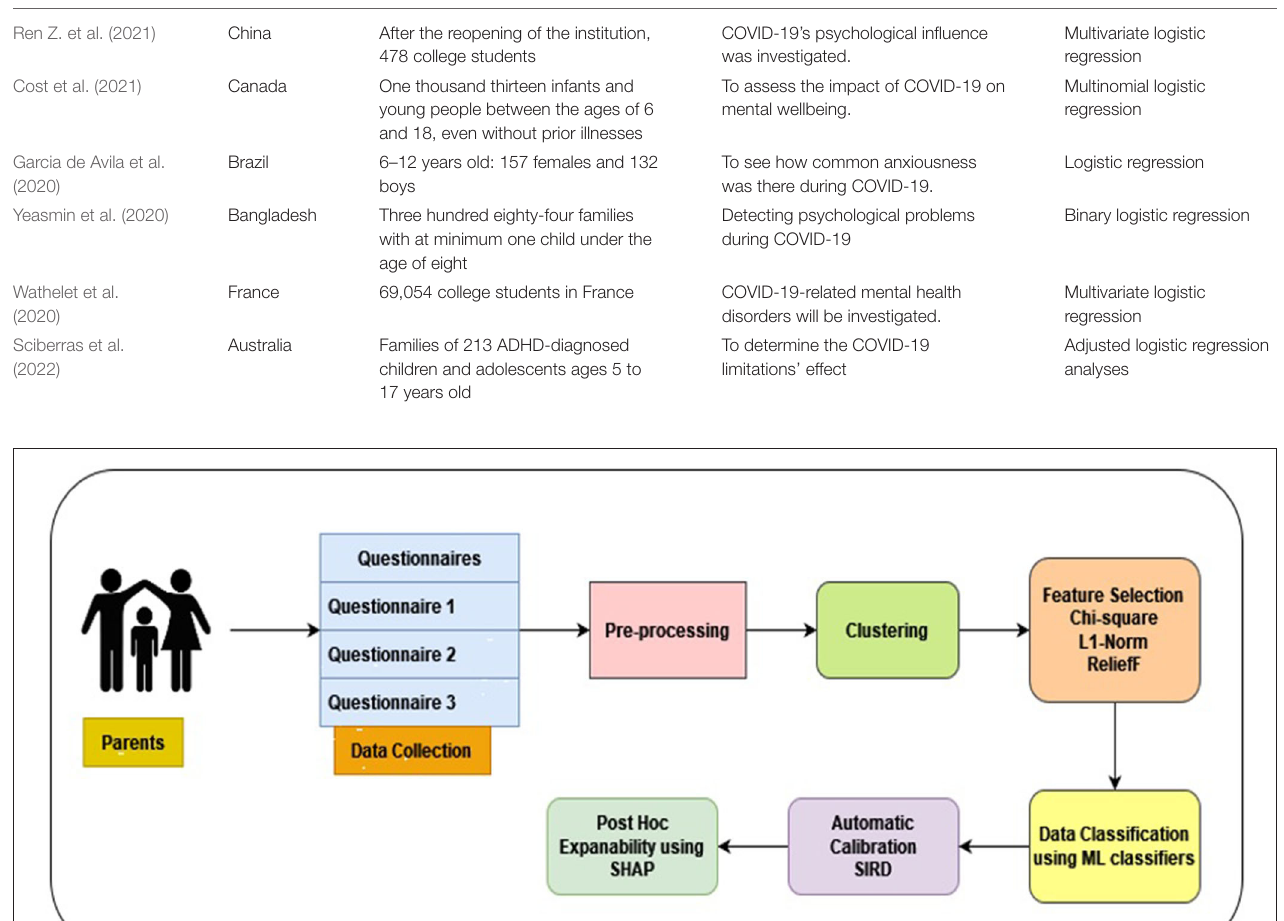
FIGURE 1 | Architecture of proposed